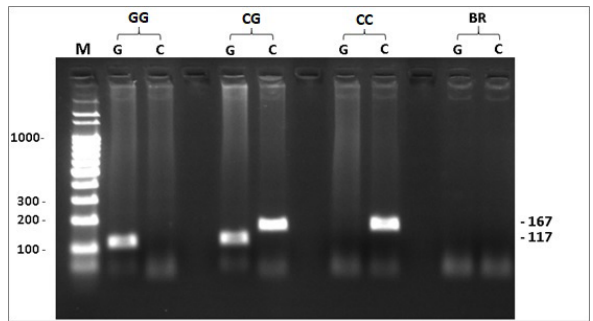
Figure 1 – Electrophoretic pattern of allele specific PCR of rs527616 (C>G), located in the lncRNA AQP4-AS1. M: Molecular weight marker, GG: Homozygous sample, CG: heterozygous sample, CC: homozygous sample, BR: white control. Expected fragment size: C-167 bp and G-117